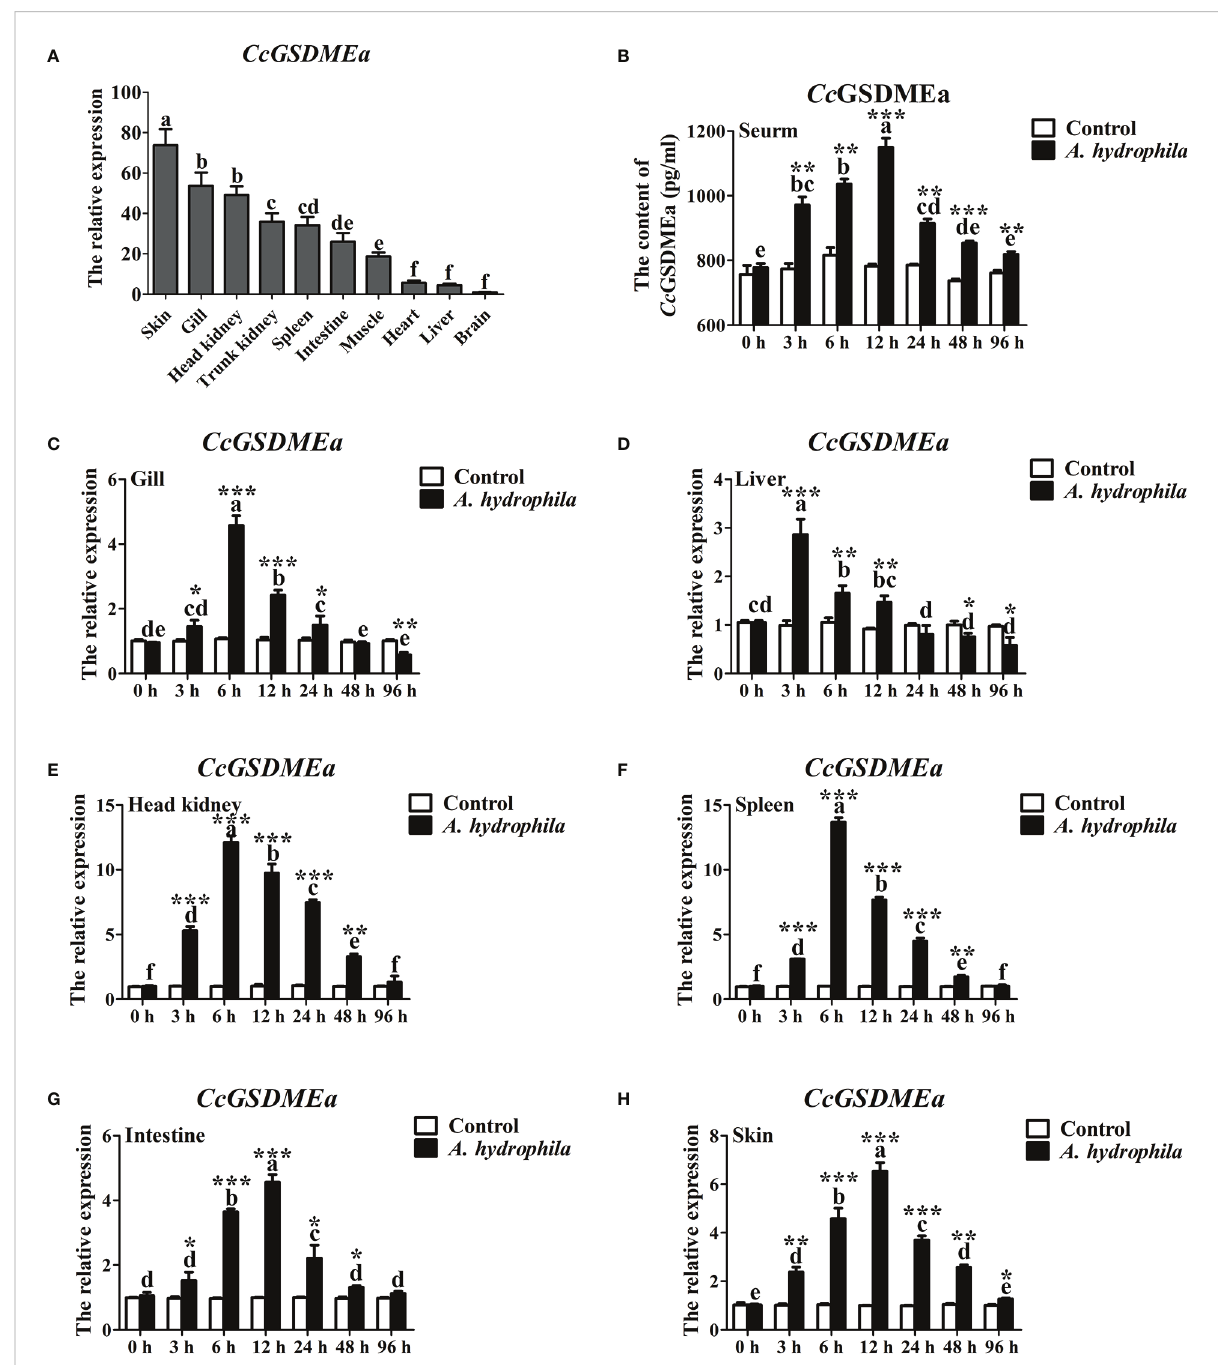
FIGURE 2 Expression pro fi le of Cc GSDMEa after A. hydrophila challenge. (A) Tissues distribution of CcGSDMEa in healthy C. carpio . The lowest expression level in brain was chosen as calibration (set as 1), and the relative expression of CcGSDMEa in other tissues was represented as fold-changes to the calibration. (B) The protein expression levels of Cc GSDMEa in serum after A. hydrophila challenge. (C-H) The mRNA expression levels of CcGSDMEa in different tissues after A. hydrophila challenge. The control group was chosen as calibration (set as 1). The data were expressed as mean ± SD (n = 3). Signi fi cant difference between the different time points were analyzed using one-way ANOVA followed by Tukey ’ s test, and presented with the different lowercase letters in the group challenged by A. hydrophila ( P< 0.05), and the same letter was indicated no signi fi cant difference ( P > 0.05). The signi fi cant differences between the A. hydrophila challenge group and the control group at the same time point were analyzed by student ’ s t test and indicated with asterisks ( * , P < 0.05; ** , P < 0.01, *** , P <